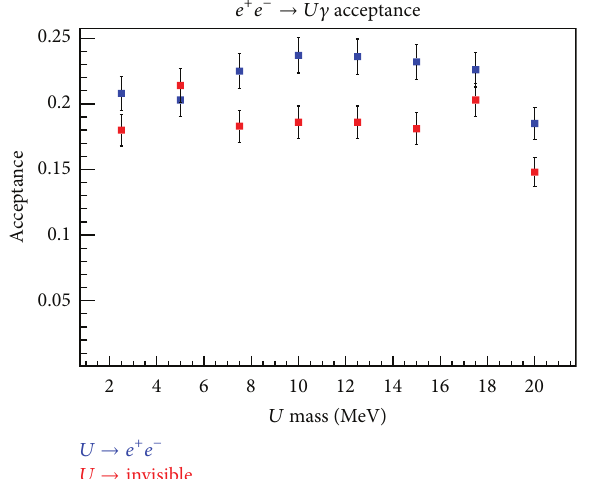
Figure 20: Expected exclusion limits in the 𝜖 − 𝑀 𝑈 plane in case of no signal.